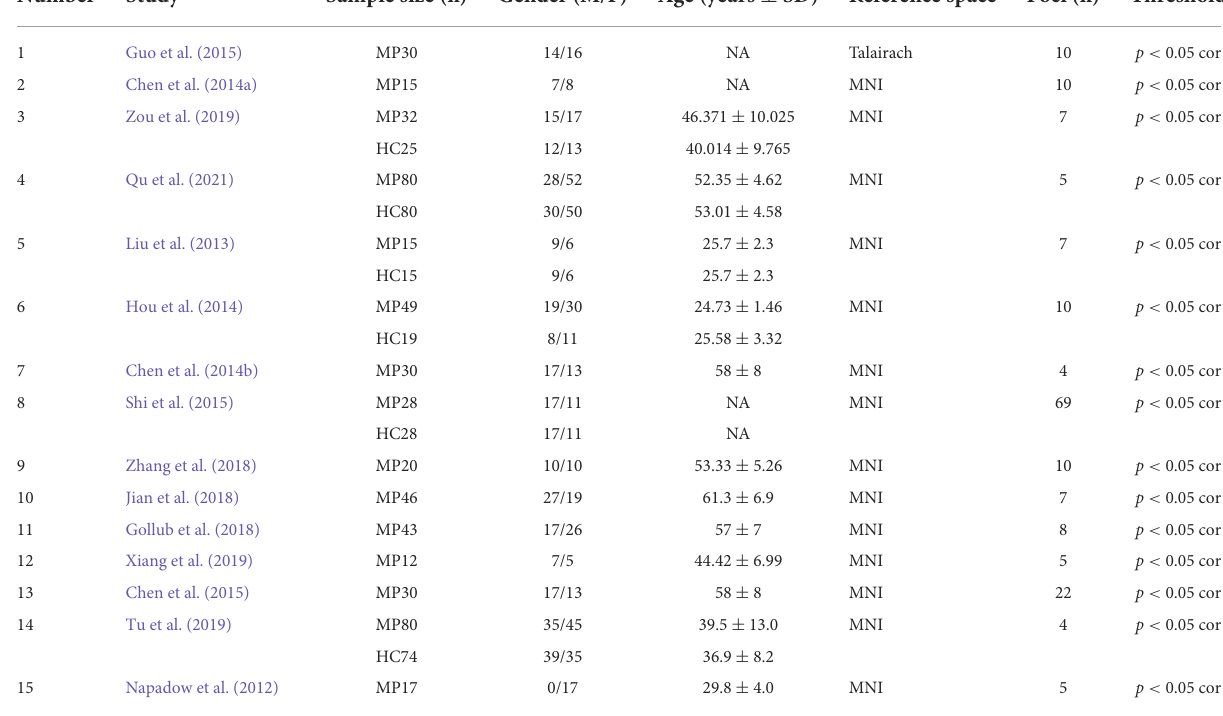
TABLE 2 Overview of the 15 studies included in the